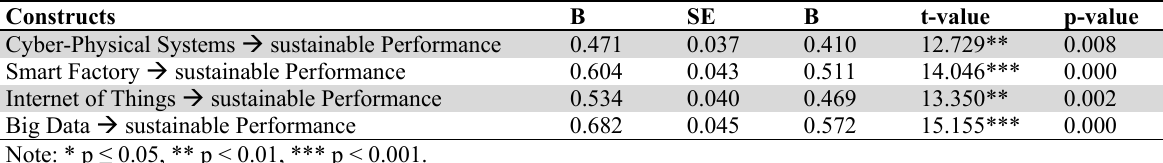
Fig. 2. SEM for testing the impact of digital transformation dimensions on sustainable performance The results indicated that the chi-square to degrees of freedom ratio (CMIN/DF) was 2.135, thus it was an appropriate value being less than 3 the upper threshold of the indicator (Shi et al., 2019). The goodness of fit index (GFI) values, the comparative fit index (CFI) and the Tucker-Lewis index (TLI) were at the minimum approved limit for these indicators (Villarreal& Jorgensen, 2020). while the value of root mean square error of approximation (RMSEA) was 0.036 which is lower than the upper threshold of 0.08 (Xia& Yang, 2019). According to the results included in Fig. 2, it was clear that the structural model used had a construct validity, and the values of the standardized and unstandardized impact coefficients listed in Table.3 were sound reliable. The summary of the